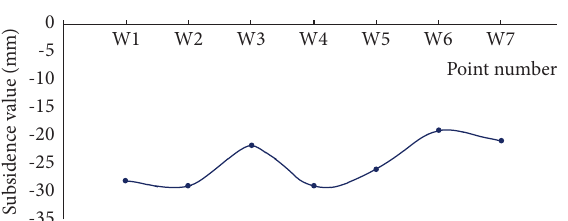
Figure 19: Subsidence curve of line 2.